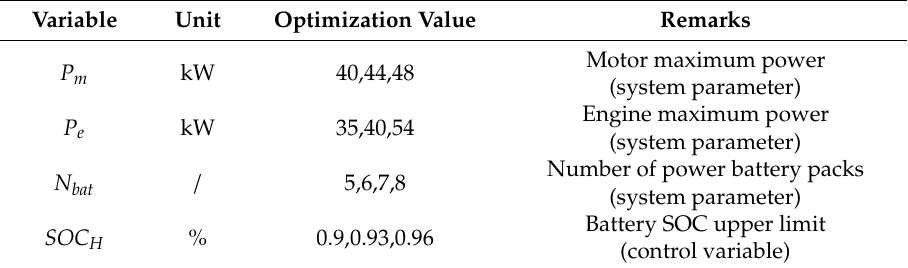
Table 3. Optimization Parameter of